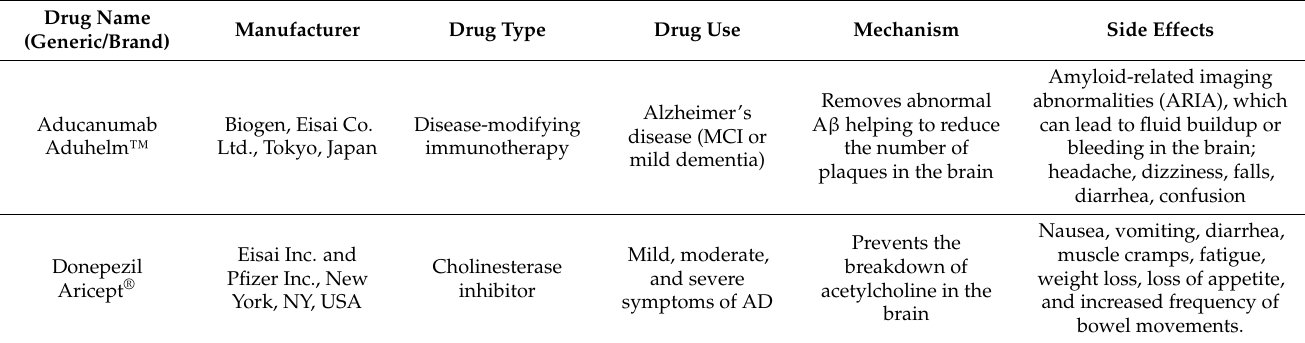
Table 1. FDA approved drugs for the treatment of AD (Adapted from Medications for Memory Loss|Alzheimer’s